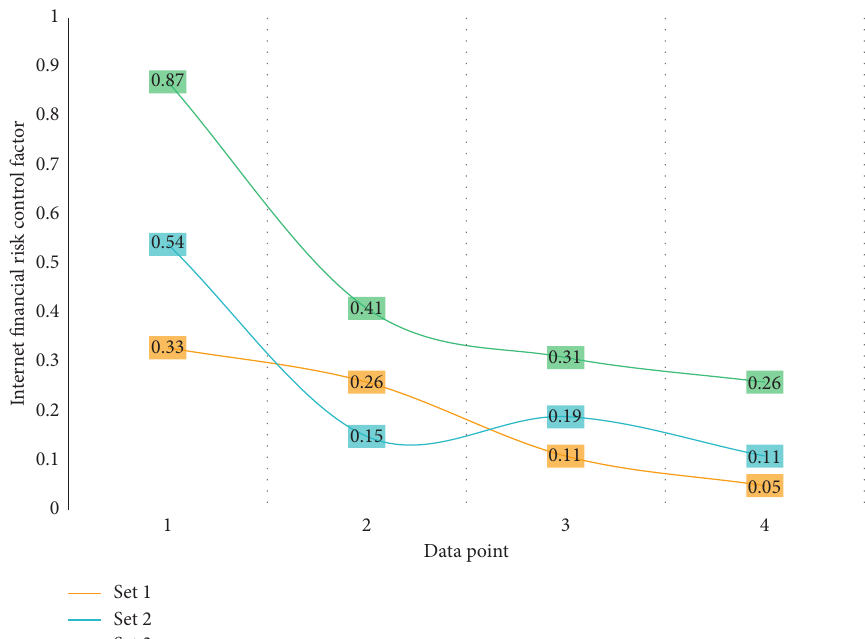
Figure 6: Internet finance risk control factor